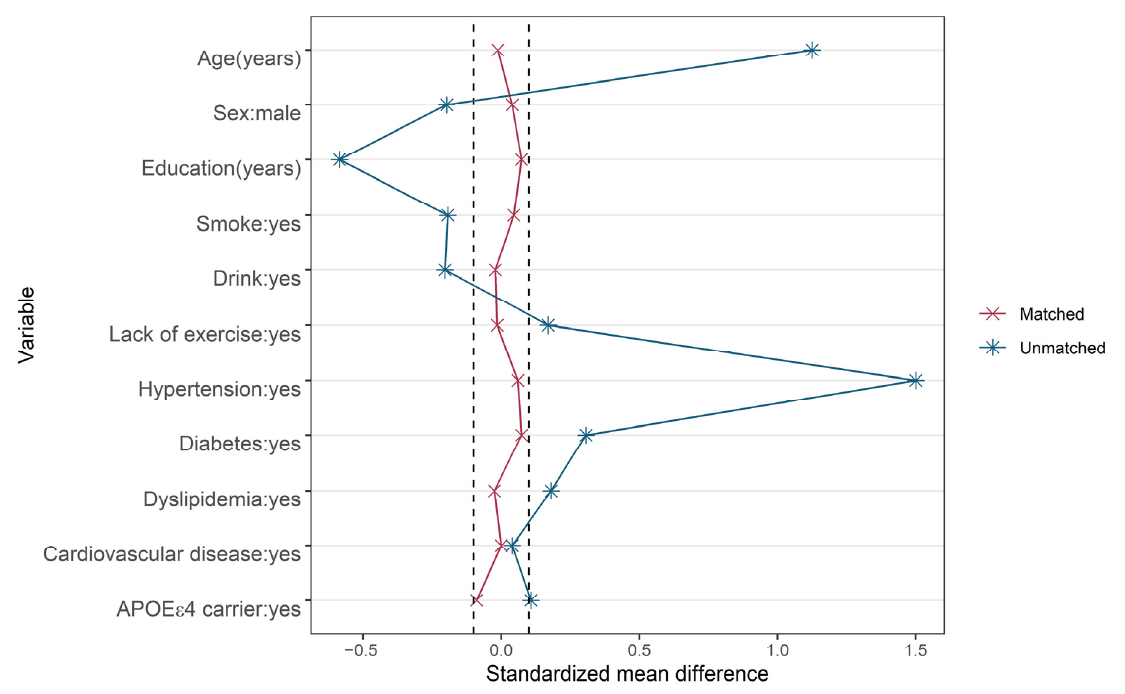
Figure 3. Love plot of standardized mean differences before and after propensity-score matching. The vertical dashed line indicates standardized mean difference = ±0.1. Table 6. Sensitivity analysis of relationship between PP and cognitive decline.